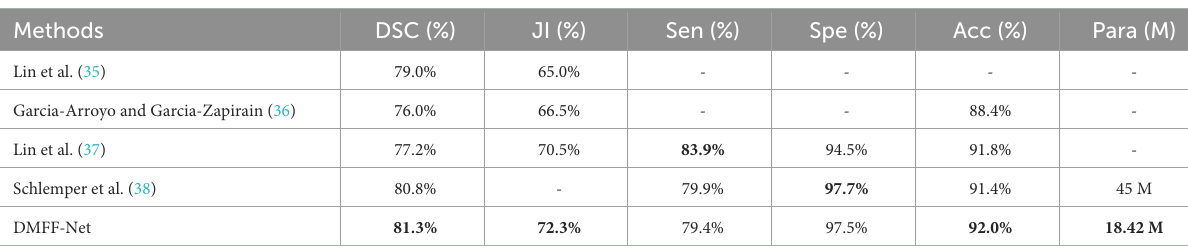
TABLE 8 The comparison with the latest works on ISIC